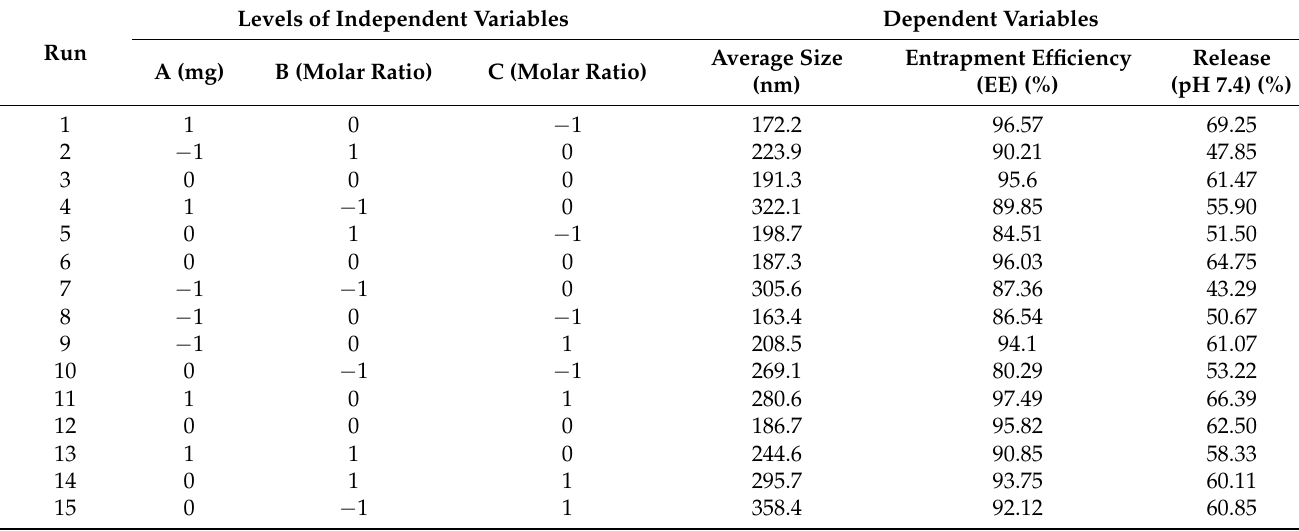
Table 2. Design of experiments using the Box–Behnken method to optimize the